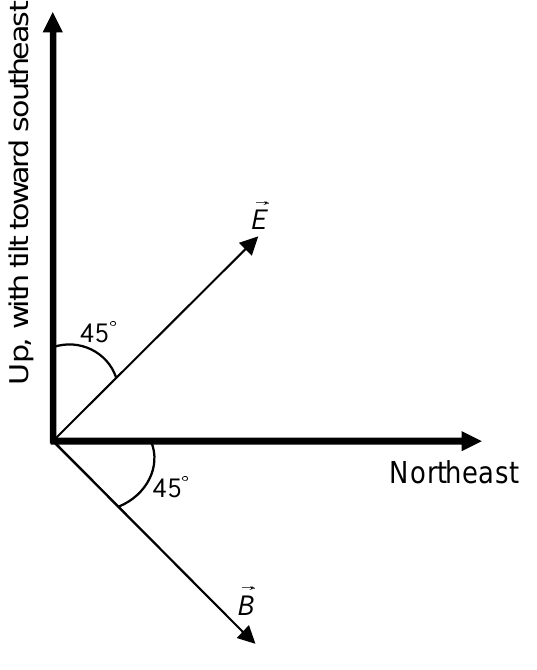
Figure 1: Axis orientation for Figures 2 through 5. The Fig. 1. Axis orientation for Figs. 2 through 5. The coordinate axes, ~E ~B coordinate axes, , and , all lie in the planes of the figures. E , and B , all lie in the planes of the figures. A uniform wind field of 45 m/s to the east, and 22 m/s to the south, is applied in the F-region. There is no background (i.e. not caused by polarization of the E s layer) electric field. A 0 . 6 km half width Gaussian density profile is located at the zonal wind shear node on the E-region grid, and a 120 km half width Gaussian density profile is located on the F-region grid. The ion-neutral collision frequency is computed from a curve fit to data given by Johnson (1961), with the E s layer located at an altitude of 100 km. The ratio of the E s layer FLI Hall conductivity to the F layer FLI Pedersen conductivity is = 1 . 8. This leads to a ratio of E set to 6 H s layer FLI Ped- 6 PF ersen conductivity to F layer FLI Pedersen conductivity of 6 PE = 0 . 06. Details of the simulation method may be found 6 PF in Cosgrove (2006a). The simulation results are presented in Figs. 2 through 5. The figures show cross sections of the E s layer and F layer densities in grey scale, and the electric field at the equilib- rium altitude of the E s layer. The scales for all figures are in kilometers, except for the y-axis of the electric field figures, which is in mV/m. The orientation of the coordinate axes is summarized in Fig. 1. The axes are defined so that both B and E lie in the figure plane. The x-axis is northeast, and B makes a 45 ◦ angle with the x-axis, directed from top left to bottom right. The electric field E is perpendicular to B , with positive defined from bottom left to top right. The sacrifice for making B and E lie in the plane of the figure is that the y-axis is directed upward, and a little toward the southeast. The x-axis, however, is exactly